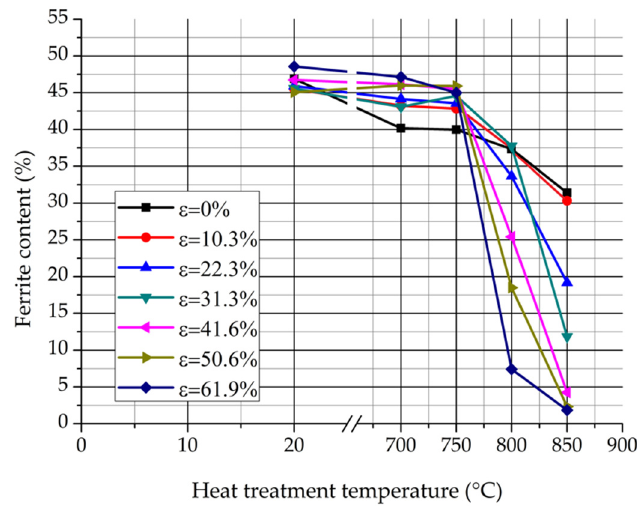
Figure 8. δ -ferrite contents vs. the heat treatment temperature measured by the DC magnetometer.